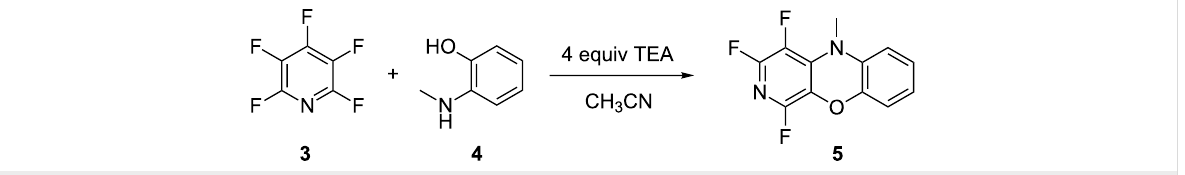
Scheme 2: The reaction of pentafluoropyridine ( 3 ) with 2-(methylamino)phenol ( 4 ) to form the corresponding fused polycyclic heterocycle 5 .